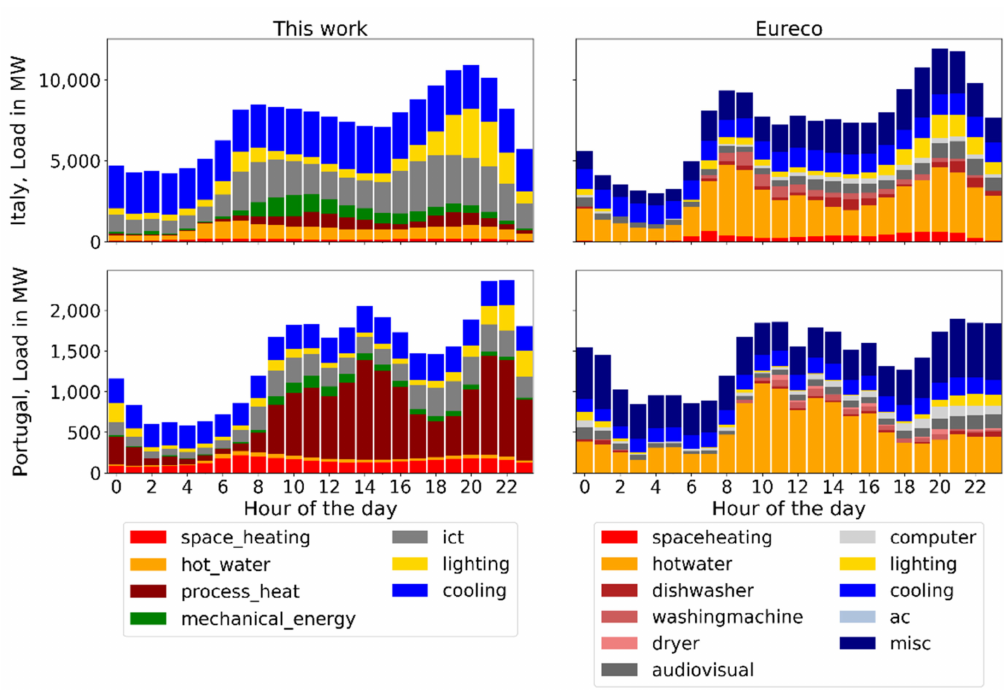
Figure 6. Yearly average load curve of this work compared with EURECO measurements for Italy (above) and Portugal (below). Values are grouped by the hour of the